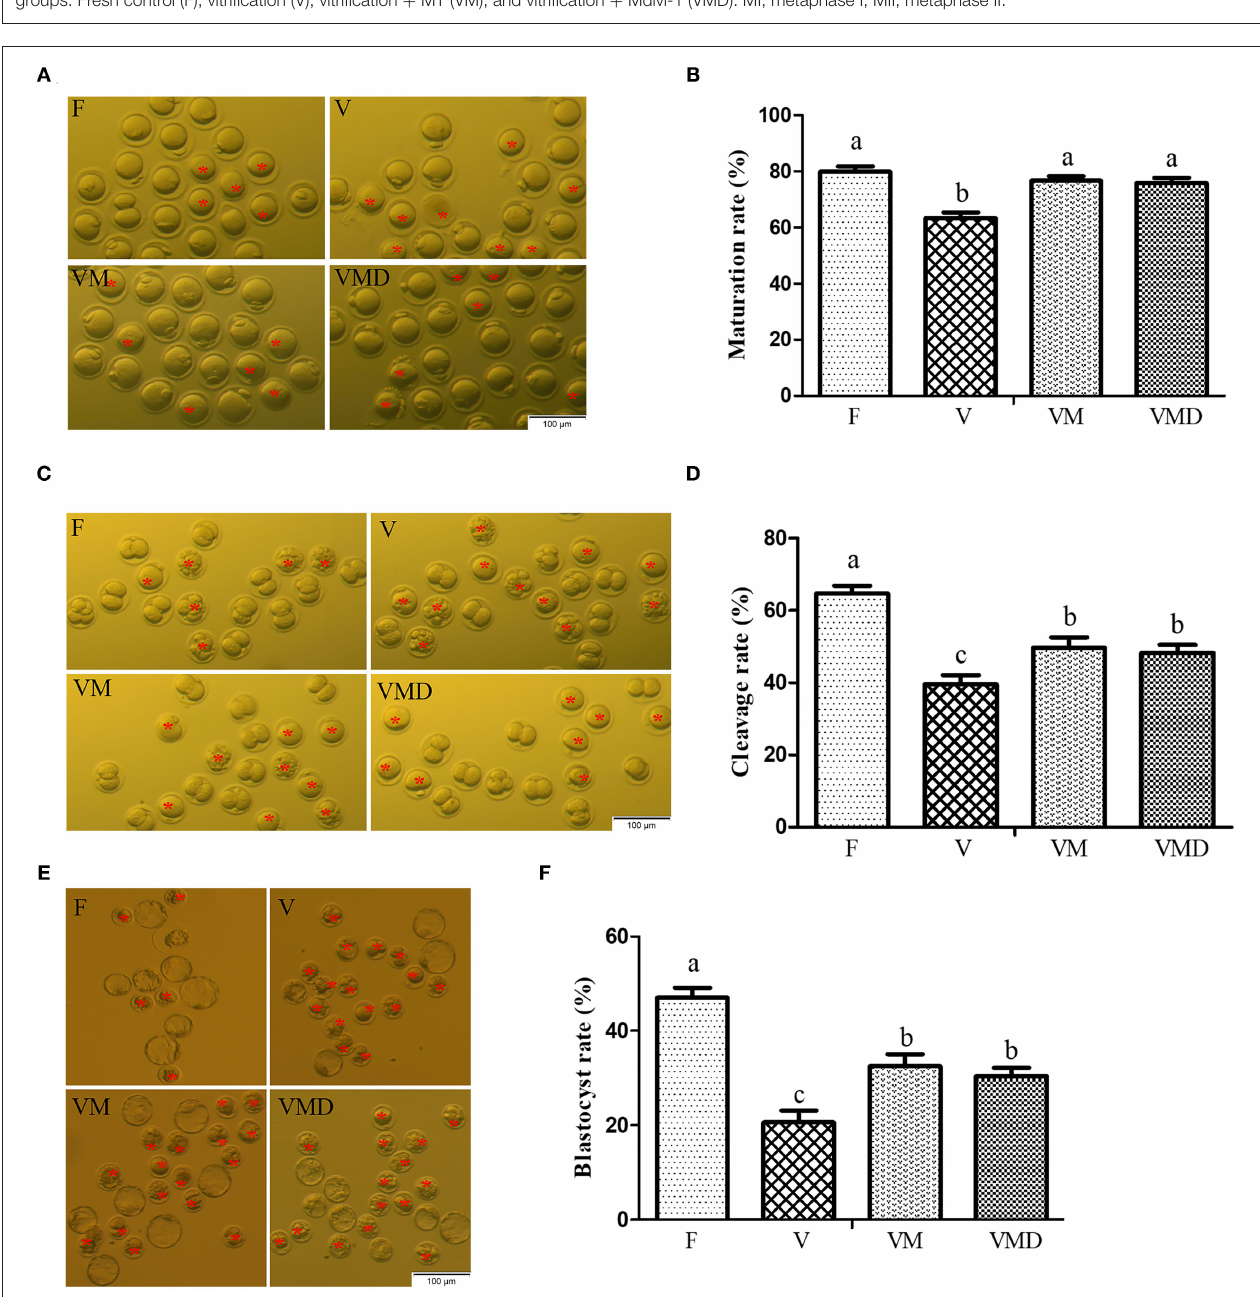
FIGURE 2 | mouse MI and MII oocytes. Scale bar, 50 µ m. (D) Fluorescence intensity of p-Drp1 (Ser616) was recorded using ImageJ software. In total, n = 154 MI oocytes (F: n = 36; V: n = 40; VM: n = 35; VMD: n = 43) and n = 150 MII oocytes (F: n = 40; V: n = 38; VM: n = 40; VMD: n = 32) were used in this assay. Data are presented as mean ± SEM of three independent experiments. Groups without a common superscript are significantly different ( P < 0.05 ). The four experimental groups: Fresh control (F), vitrification (V), vitrification + MT (VM), and vitrification + Mdivi-1 (VMD). MI, metaphase I; MII, metaphase II.